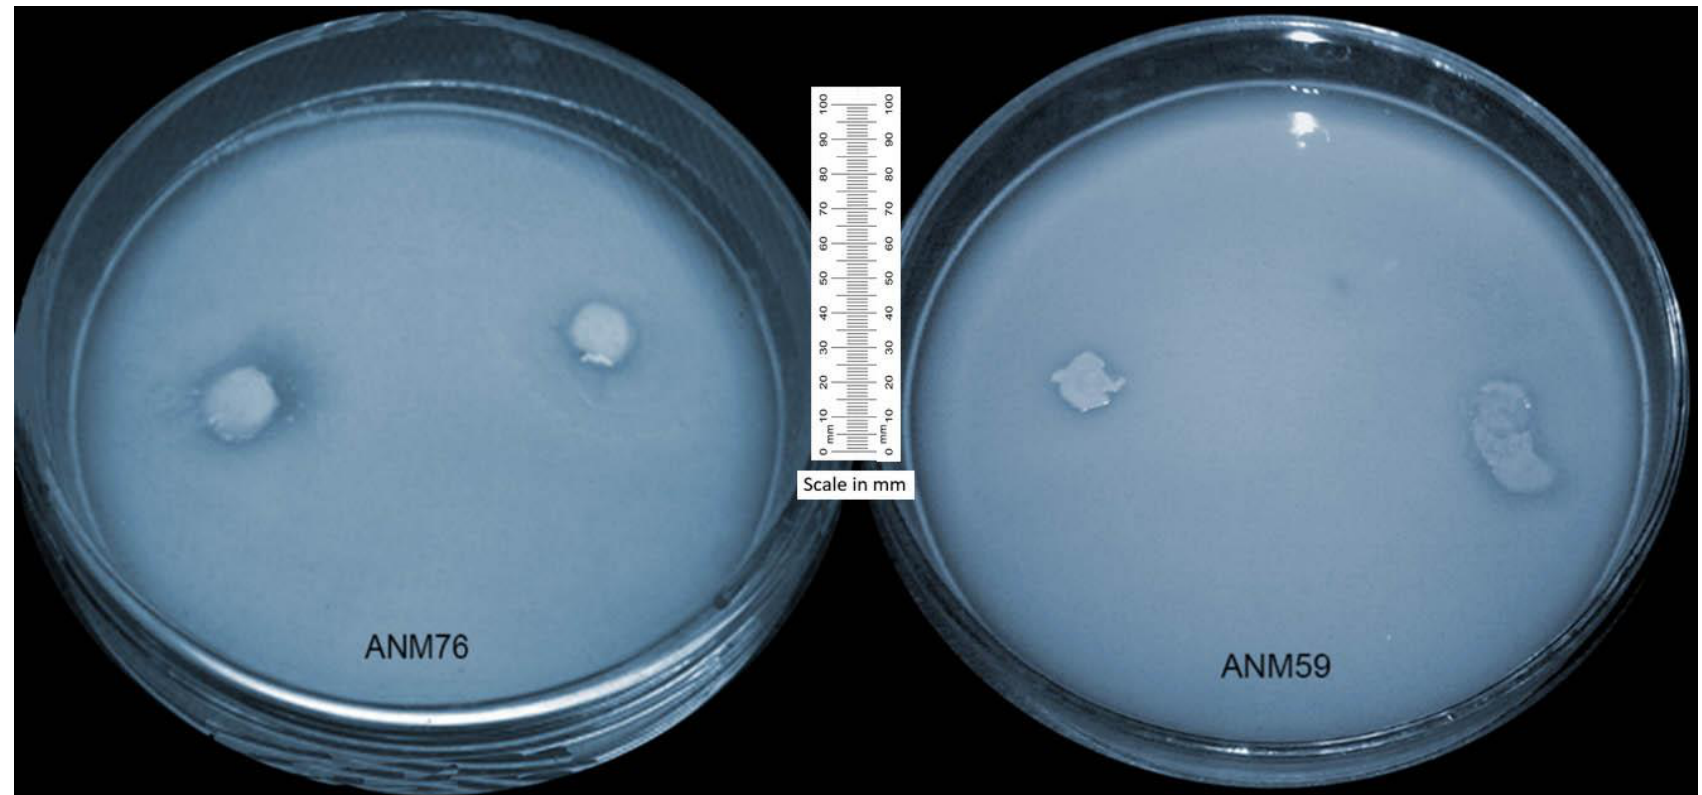
Figure 1. In vitro solubilization of inorganic phosphorus by endophytic strains ANM59 and ANM76 after 48 h of incubation at 28 ± 1 ºC. Halo zone around bacterial colonies indicated solubilization of phosphorus. Halo zone and bacterial colonies zones were calibrated through millimetre (mm) scale.